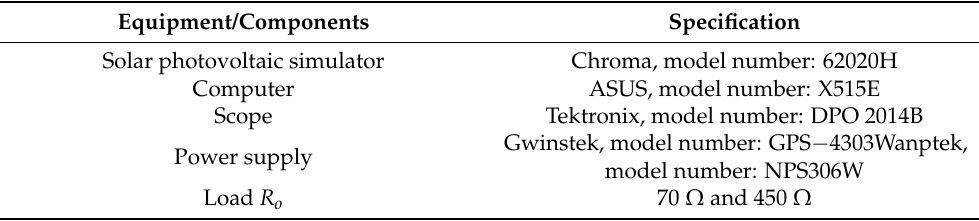
Table 5. Specifications of the experimental